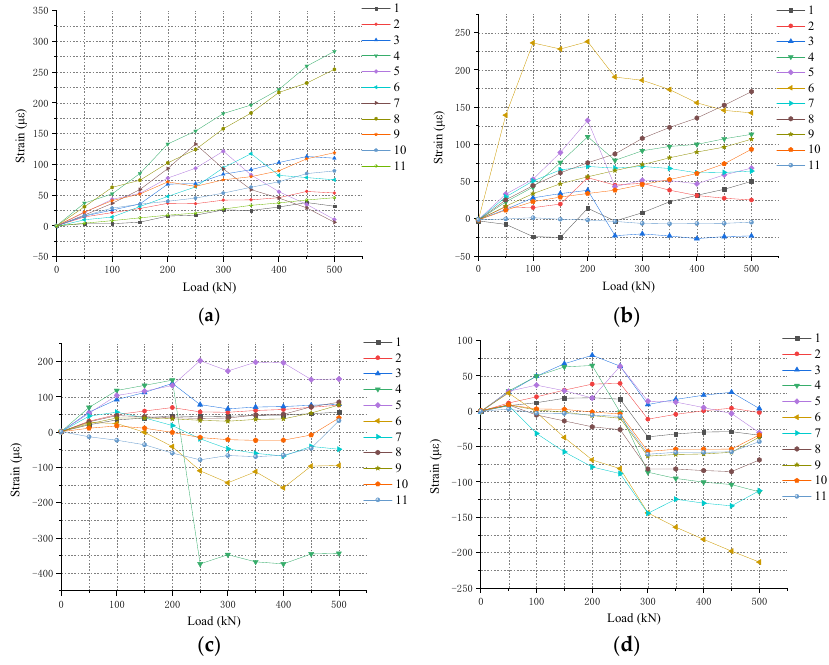
Figure 13. Strain–load curves of steel plates. ( a ) R1/4; ( b ) R1/3; ( c ) R1/2; ( d ) R2/3.